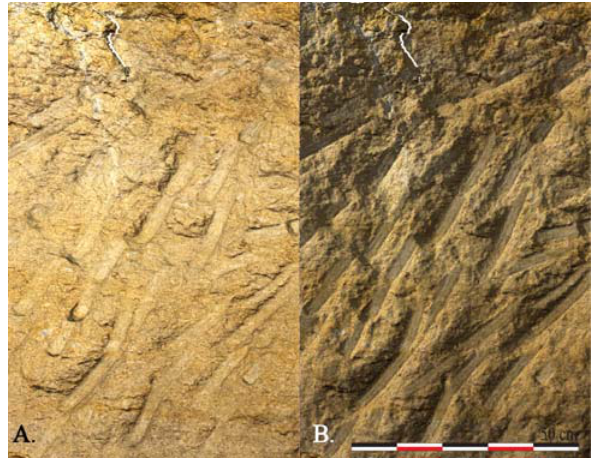
Figure 10. Wall model to analyze tool marks with different virtual light conditions